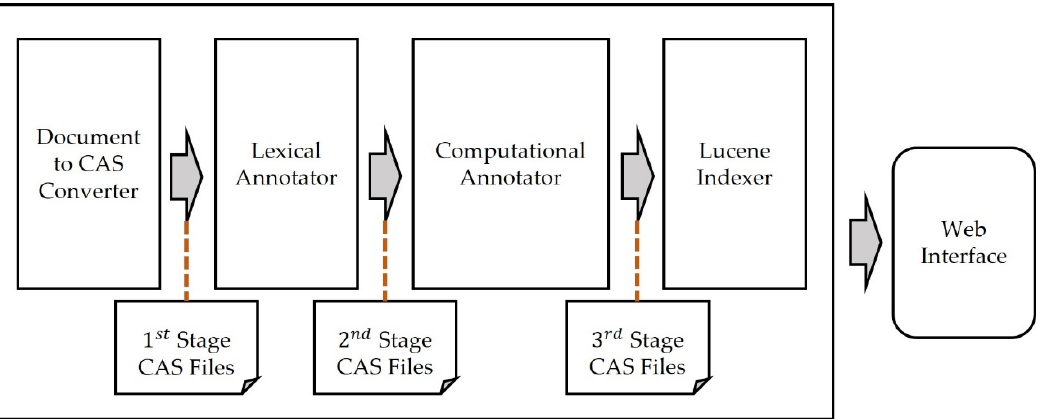
Figure 2. Pipeline of Textpresso Central.